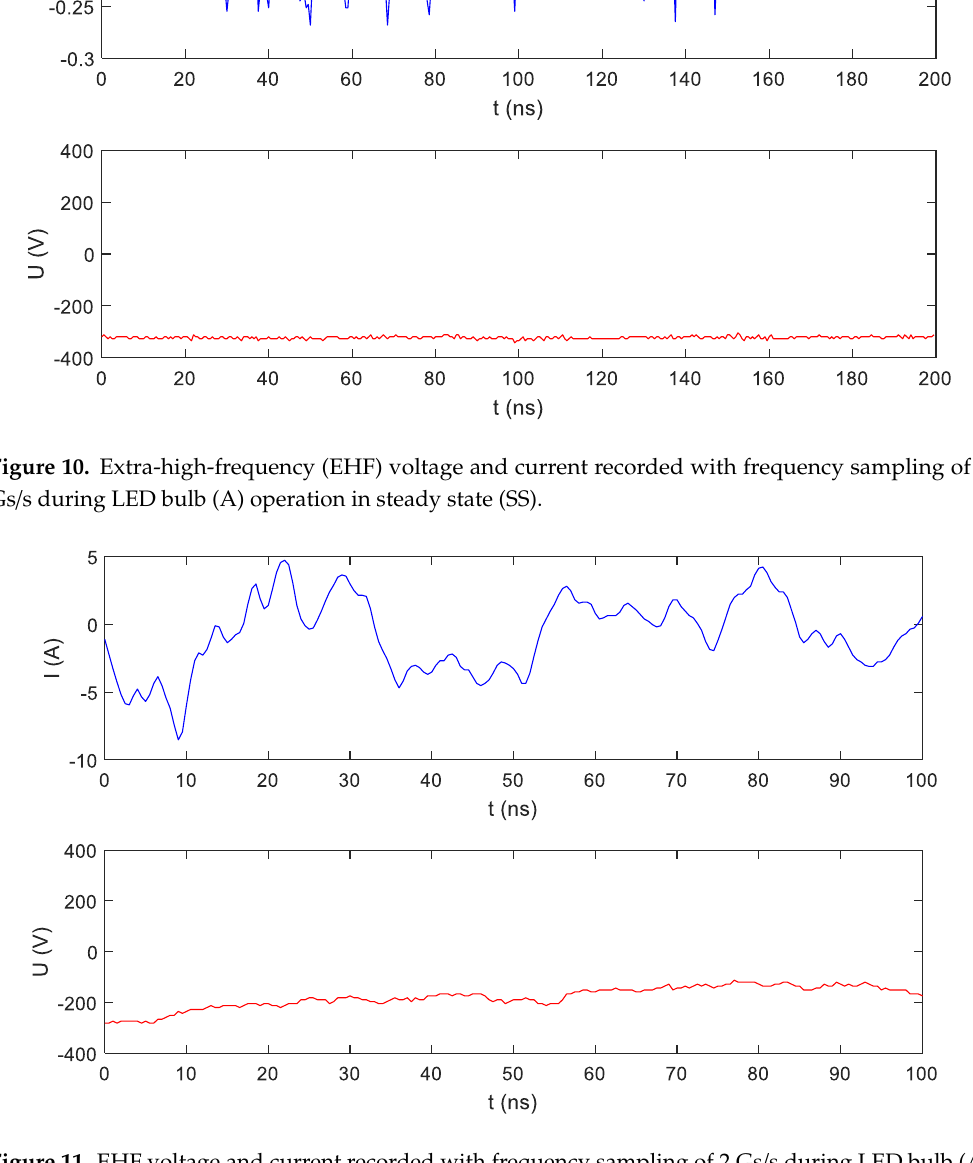
Figure 11. EHF voltage and current recorded with frequency sampling of 2 Gs/s during LED bulb (A) switching on (TS).